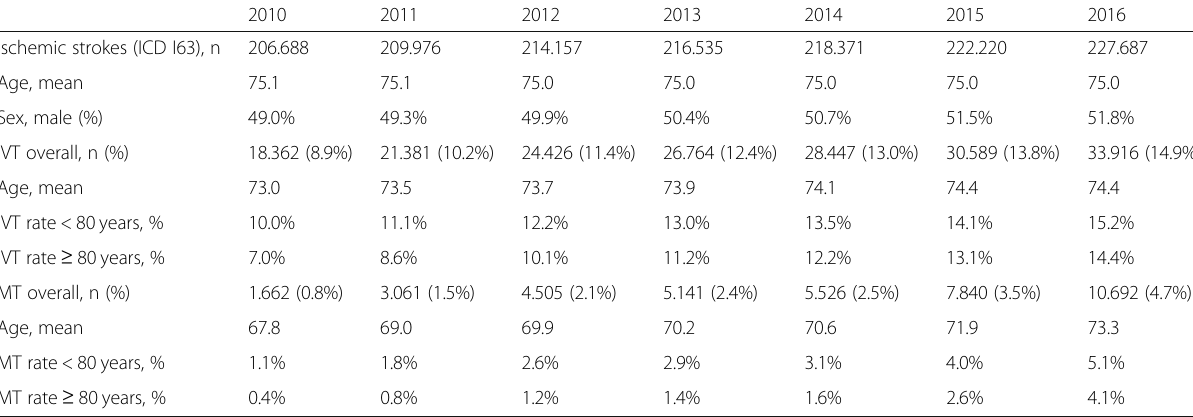
Table 1 Rates of ischemic stroke, intravenous thrombolysis and mechanical thrombectomy from 2010 to 2016 in